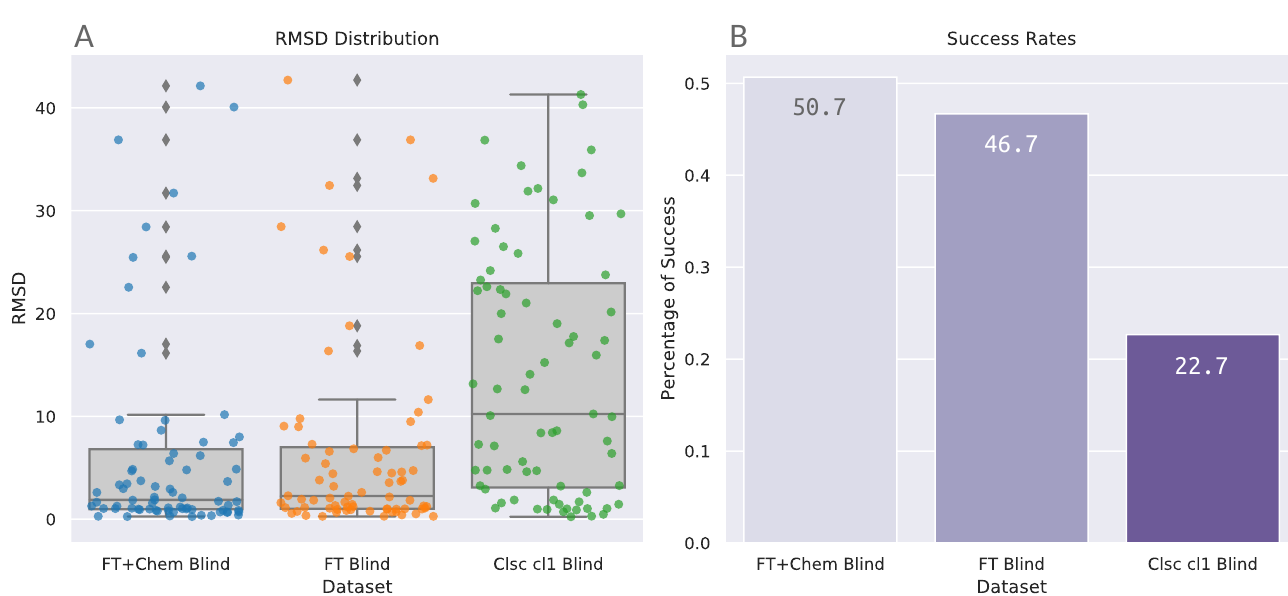
Figure 5. Summary of the benchmarking results with the Astex Diverse set. ( A ) Boxplots combined with stripplots illustrate the distribution of the RMSD results for each benchmarking protocol. ( B ) Success rates at a 2.0 Å cutoff. Numbers printed inside the bars indicate success rates expressed in percentage rounded to three significant digits.